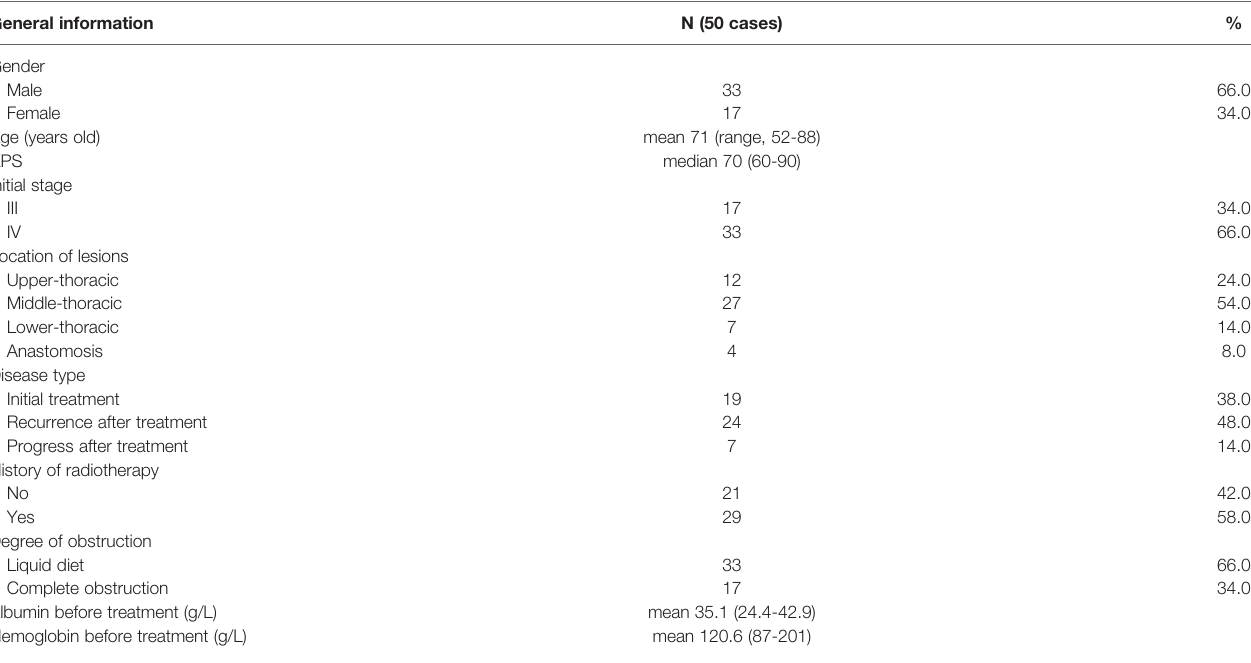
TABLE 1 | Patients ’ baseline status before